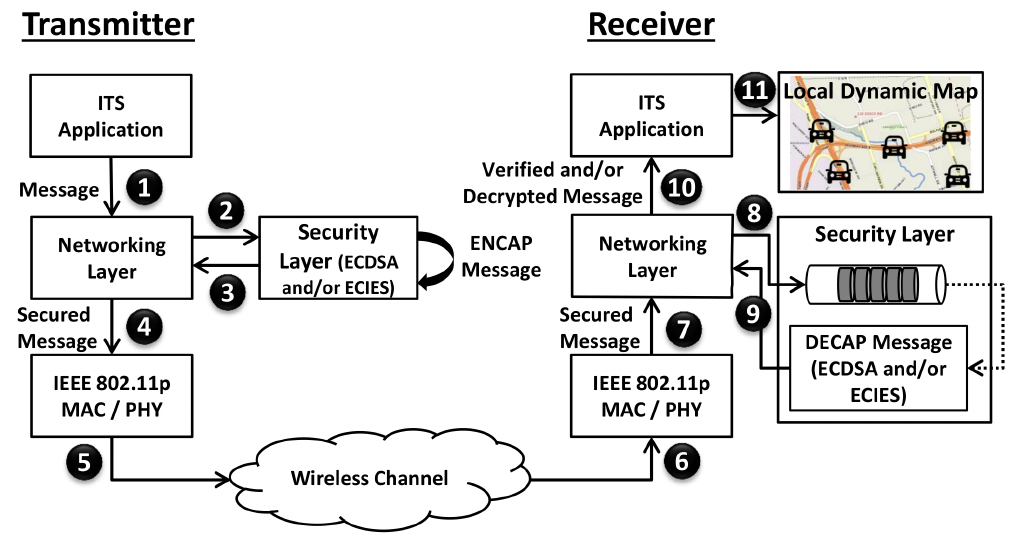
Figure 14. Secure ITS message